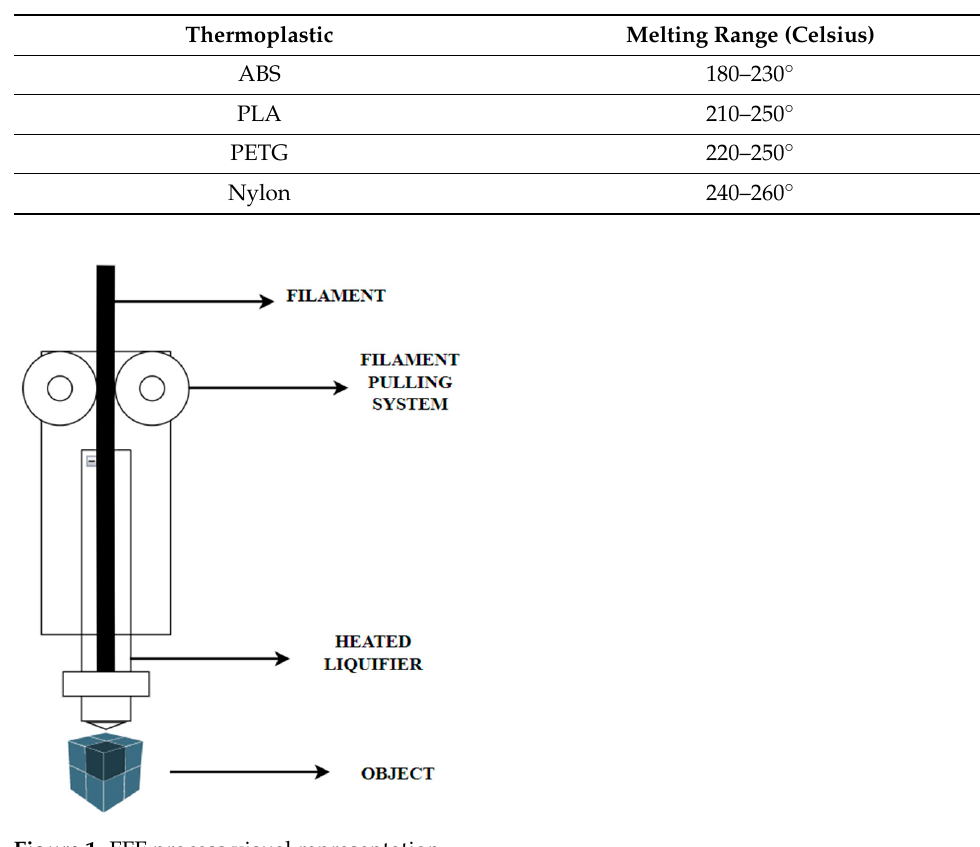
Table 1. Thermoplastics’ melting point range.